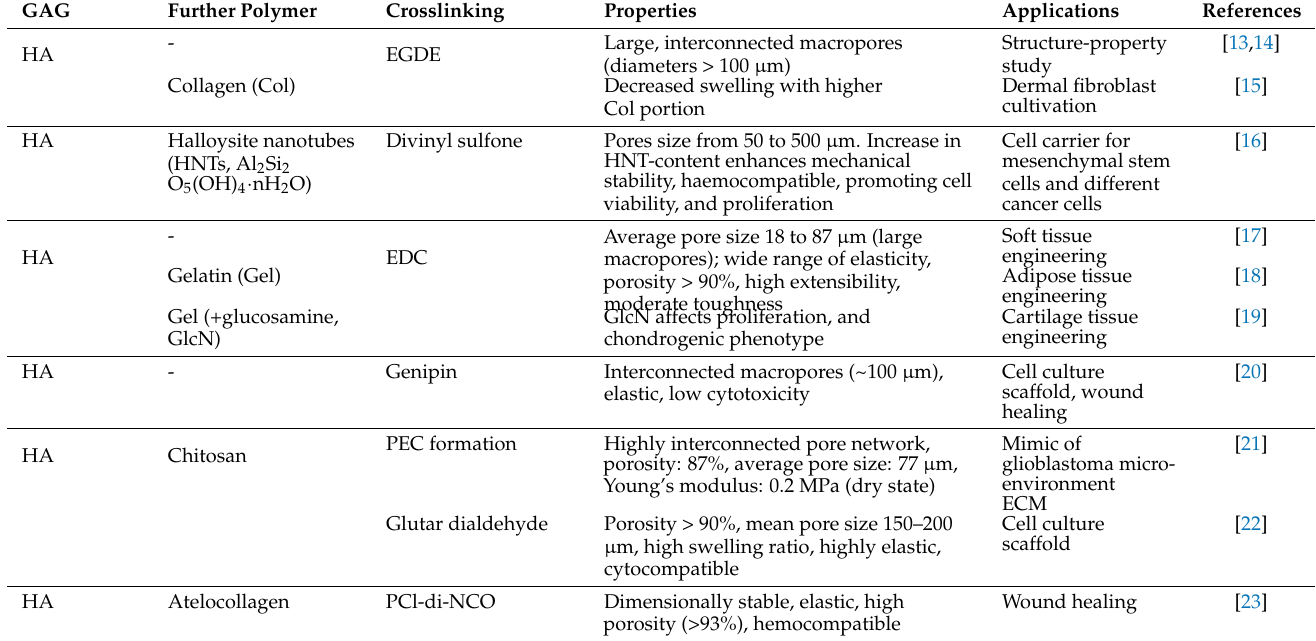
Table 1. Overview on relevant publications using hyaluronan (HA)-based cryogels.